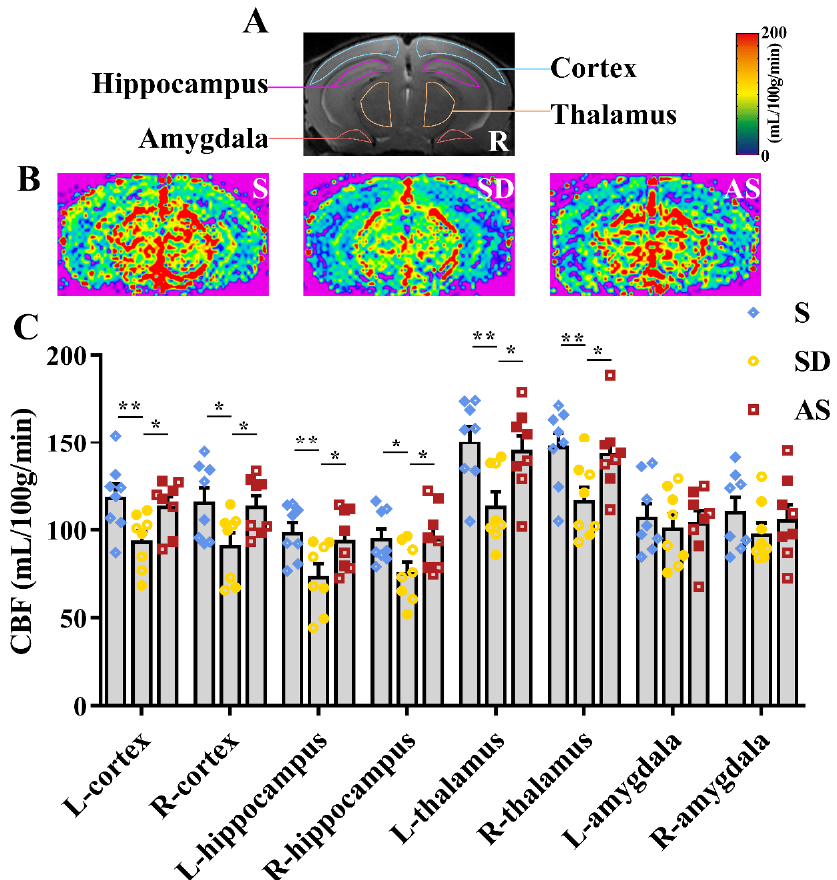
Figure 4. Acoustic stimulation increased regional CBF. ( A ) A total of 8 ROIs (bilateral cortex, hippocampus, thalamus and amygdala) for regional CBF measurement. ( B ) Representative CBF images. Red indicates high CBF, and blue indicates low CBF. ( C ), Quantitative analysis. One-way ANOVA followed by two-sample LSD t tests is used. Data are expressed as mean ± SEM. Closed dots constitute male mice, and open dots constitute female mice. * p < 0.05, ** p < 0.01.